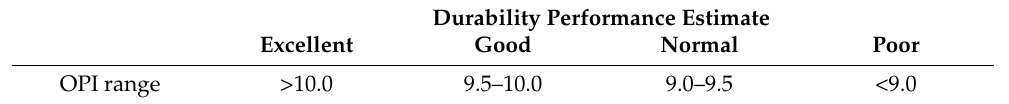
Table 5. OPI performance estimates.